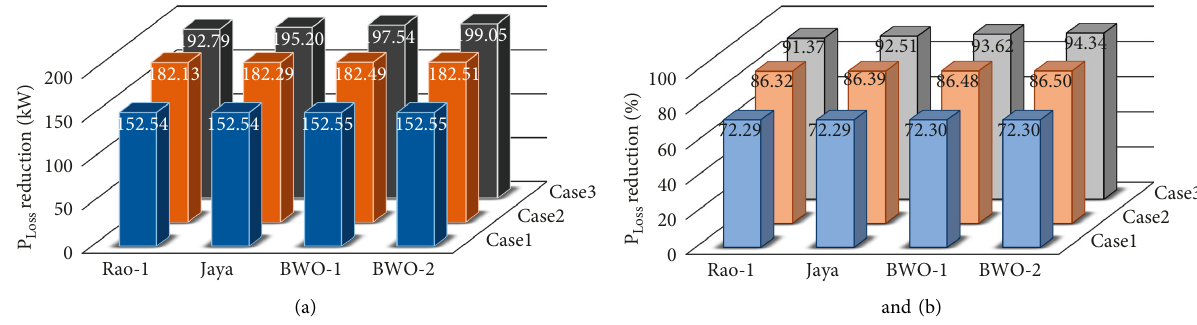
Figure 10: The power loss reductions obtained in 33-bus RDN for the studied three cases: (a) in kW and (b) in